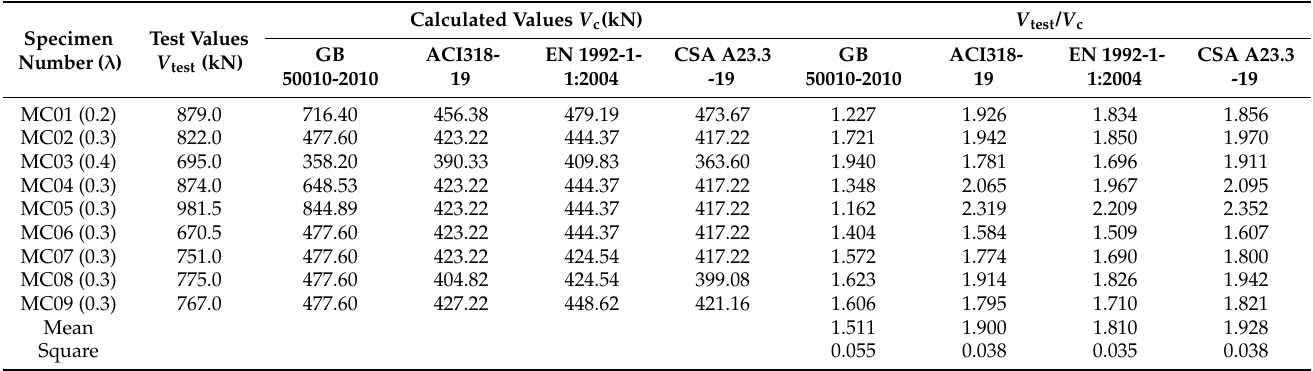
Table 4. Comparisons between experimental and calculation